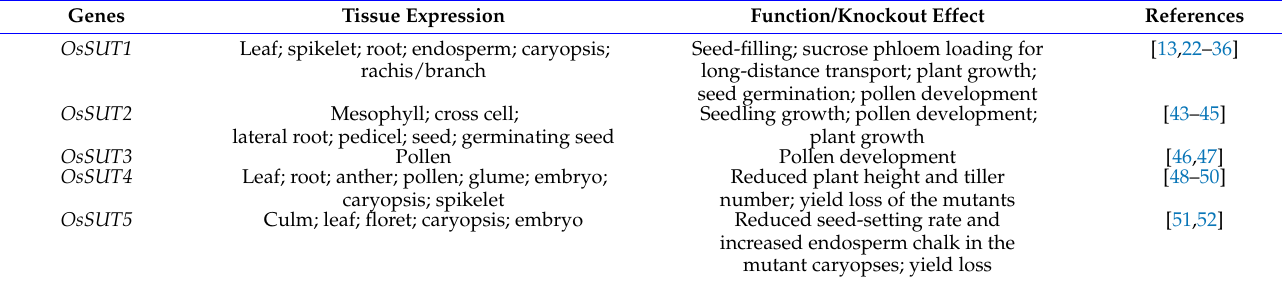
Table 1. Rice SUT genes and their physiological functions. Tissue Expression Function/Knockout